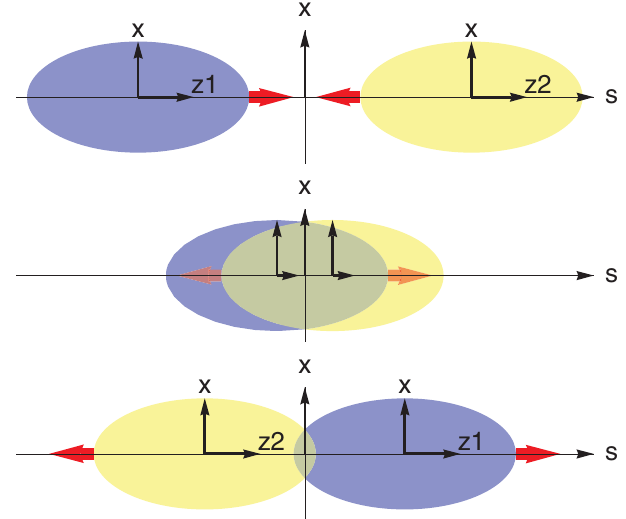
FIG. 12. (Color) Schematic view of the collision between two bunches at an IP, showing the three coordinate systems used: the s axis is fixed in the laboratory frame and with s ¼ 0 at the IP, while the z 1 and z 2 axes move with the origin fixed in the center of the two bunches. The bunch movement is indicated by the red arrows. The transverse coordinates of all systems coincide, since zero crossing angle is assumed. All distances are measured in the laboratory